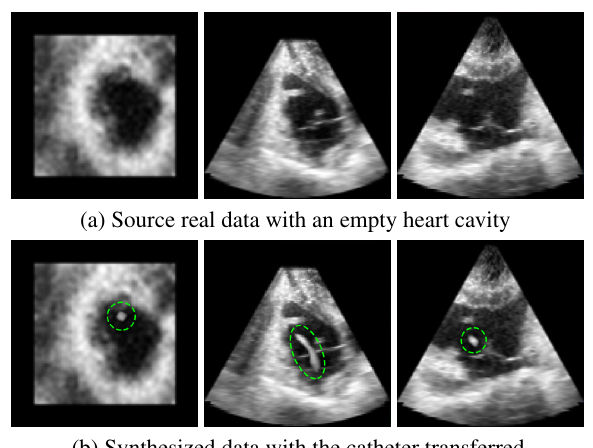
Figure 6. An example of an artificial sample synthesized by the the proposed algorithm.